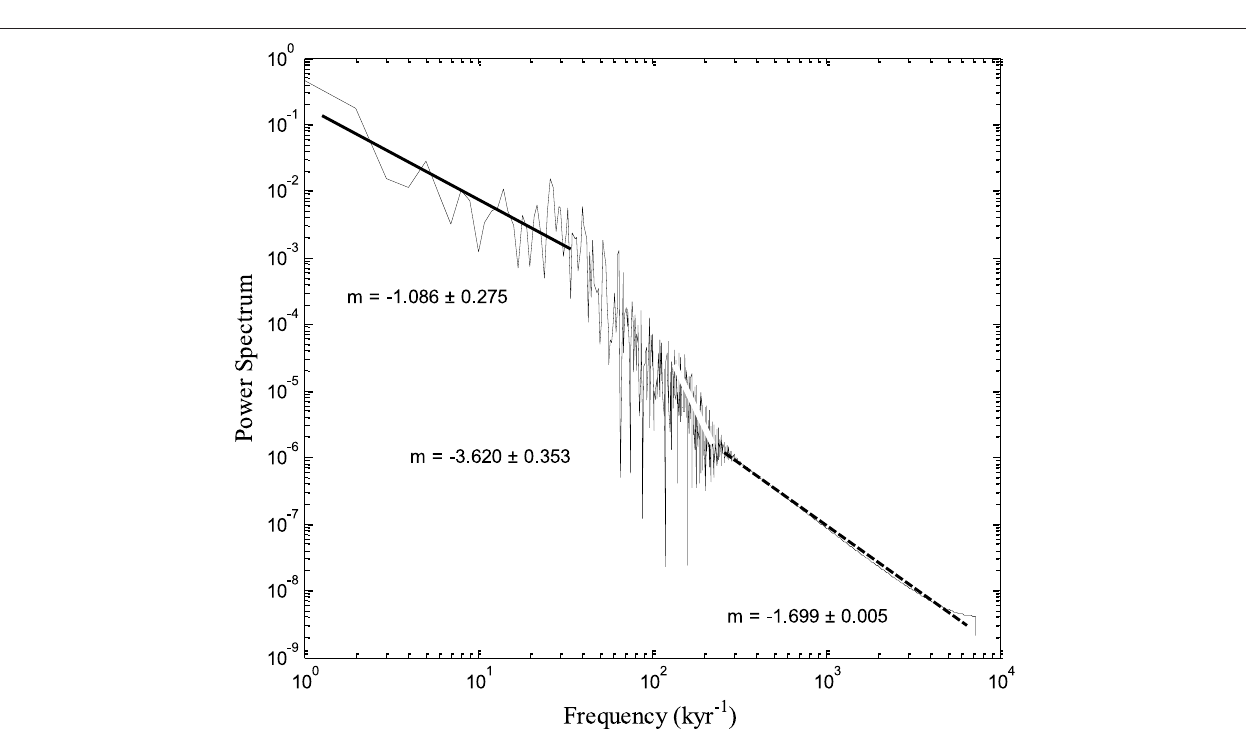
paleomagnetic models like as SHA.DIF.14K, at least in the range of parameter values of both models that we have